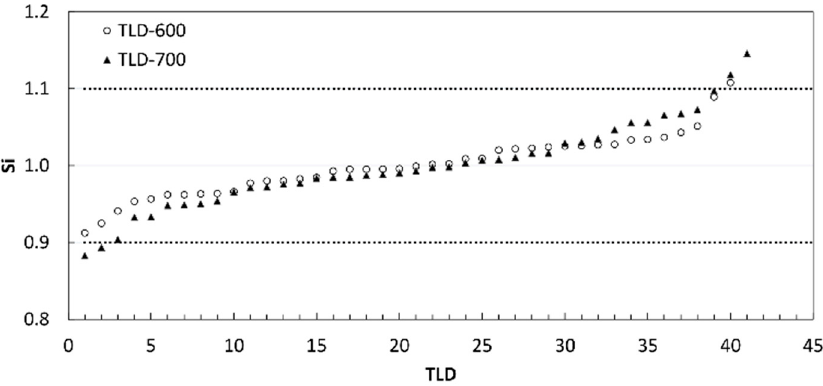
Figure 3. Relative intrinsic sensitivity factor for all Thermoluminescent Dosimeters (TLDs-600 and -700). The dot lines limit the range of acceptability of S i [0.9–1.1].